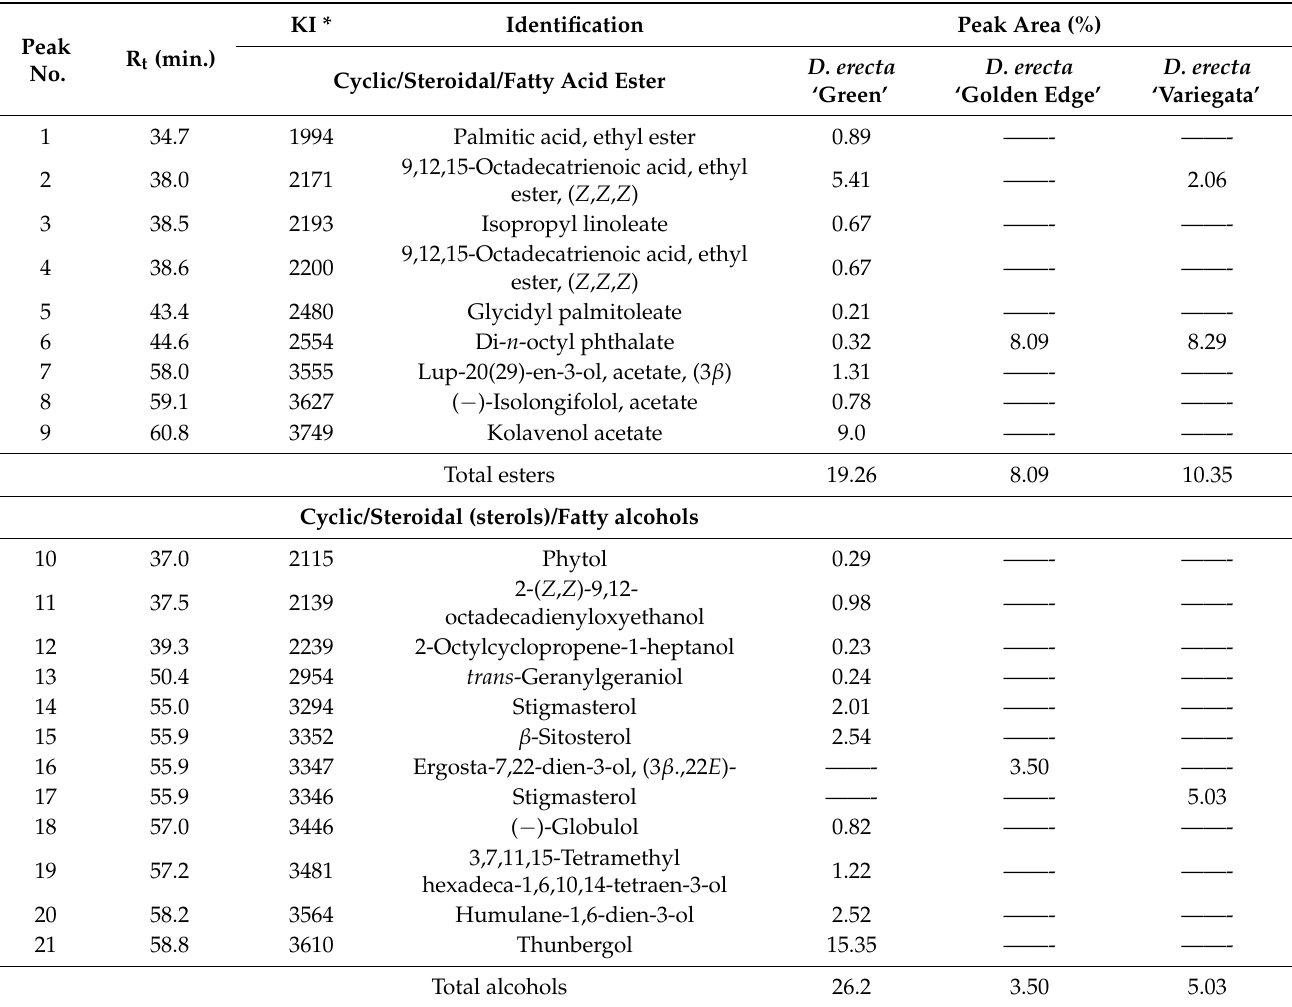
Table 1. GC-MS profiling of the hexane extracts of three different cultivars of Duranta erecta, viz. ‘Green’, ‘Golden edge’, and ‘Variegata’ on RTX-5 capillary column showing the relative percentage of